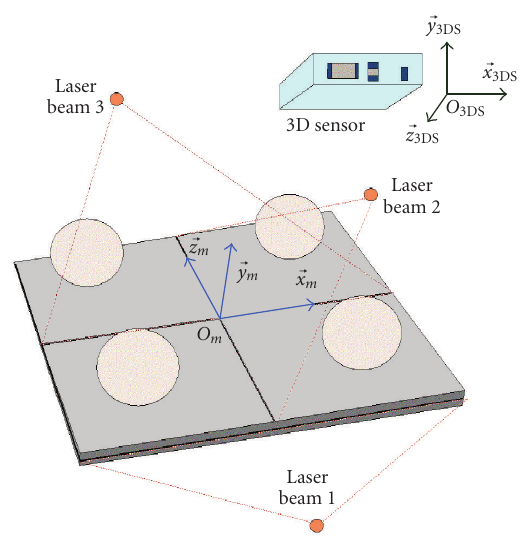
Figure 2: Calibration